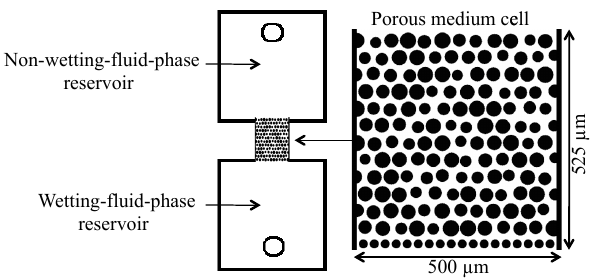
Figure 1. A depiction of the two-dimensional micromodel that was used in the displacement experiment. The solid phase consists of pore-space-free solid cylinders of varying radii distributed in the horizontal plane represented by black and the regions accessible to fluid flow by white within the porous medium